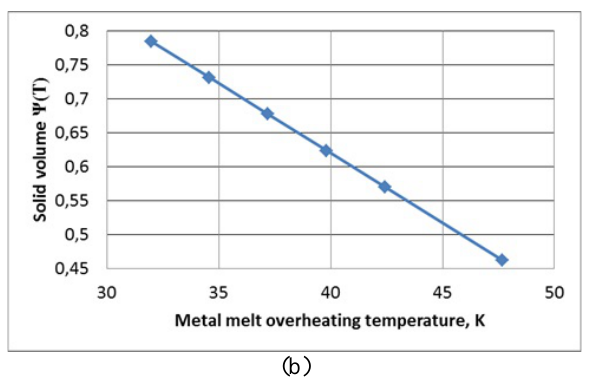
Fig. 2. Dependence of temperature factors on external pressure